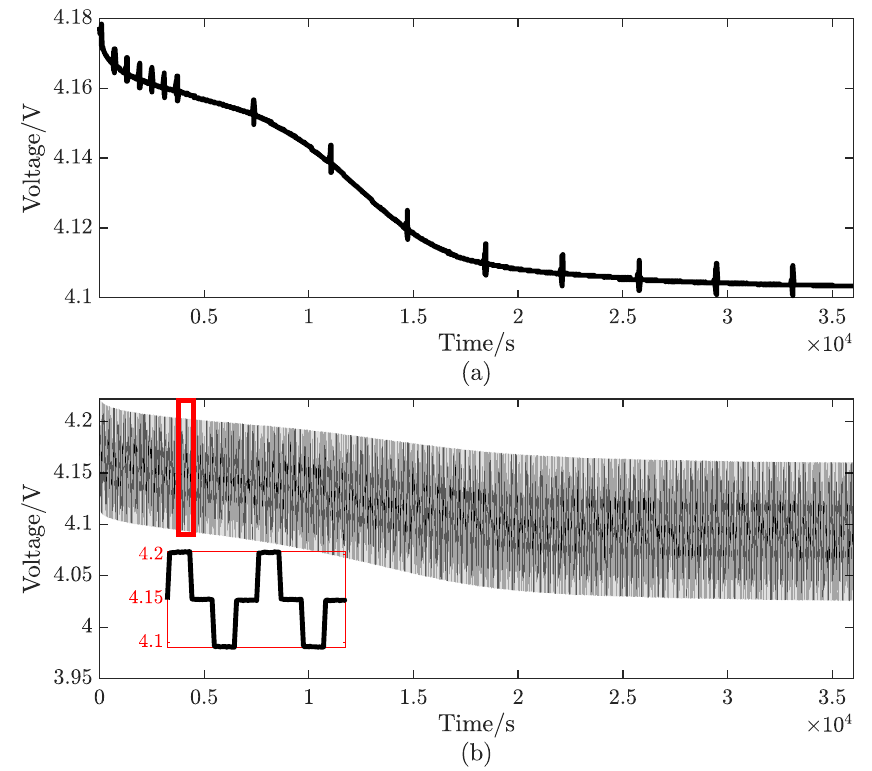
Figure 1. Voltage profiles with ( a ) electrochemical impedance and ( b ) internal resistance measure-